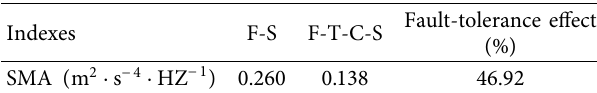
Table 9: The highest peak values of sprung mass acceleration in frequency